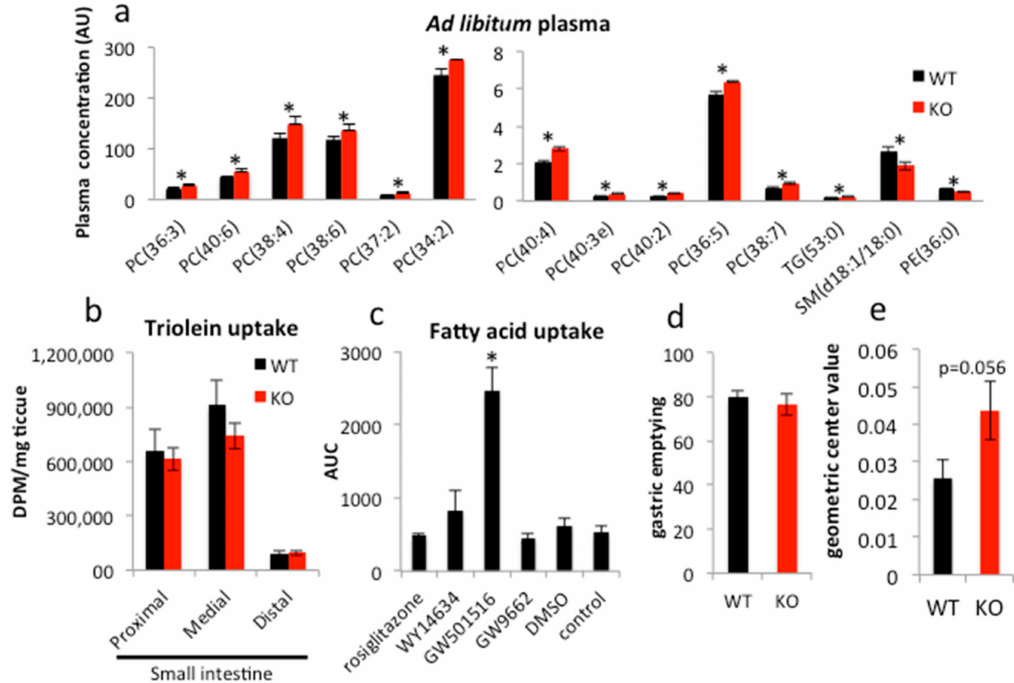
Figure 1. PPAR γ does not affect lipid uptake, but regulates intestinal transit. ( a ) Blood was collected from mice fed ad libitum and plasma lipid composition analyzed ( n = 5). ( b ) Lipid uptake was quantified by recording the radioactive tracer uptake ( 3 H-triolein) in the duodenal epithelium 30 min after labeled oil gavage (wild-type (WT) n = 8, KO n = 12). ( c ) Following 24 h incubation with the indicated compounds, fluorescent fatty acids (FAs) were added to each well and uptake by Caco-2 cells measured over 2 h ( n = 3). ( d ) WT and iePPAR γ KO mice were gavaged with FITC-dextran in canola oil and the fluorescence in the stomach and ( e ) small intestine measured. For the intestine, the geometric center was quantified 30 min after gavage (WT n = 12, KO n = 10). The Student’s t -test was performed for ( a , b , d , e ). For ( c ), one-way ANOVA with a Bonferroni post-hoc test was applied. Data are presented as means ± SEM (standard error of mean). * p <